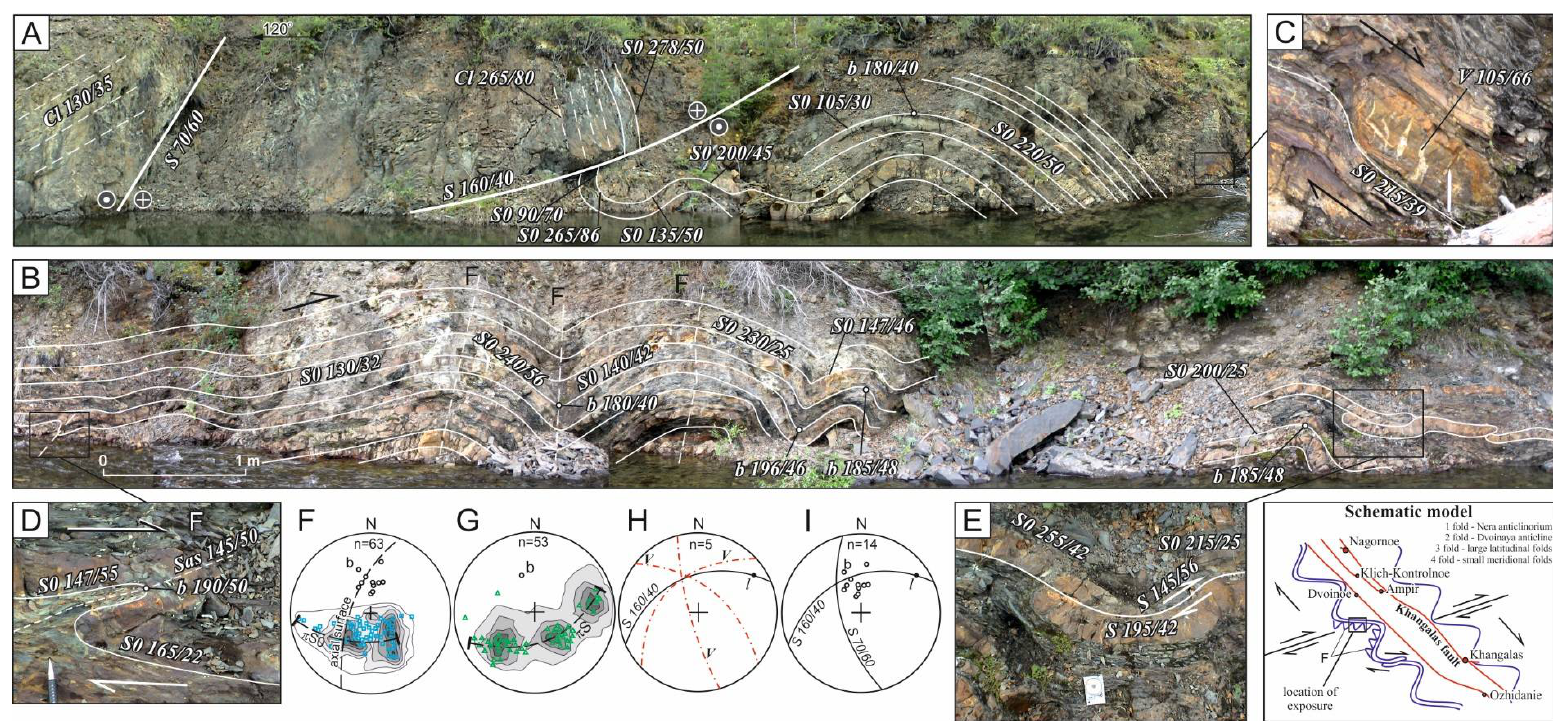
Figure 8. Dextral strike-slip deformations in Upper Triassic sandy siltstones, Mudeken Creek. ( A , B ) Fold and fault structures; ( C ) ladder veins in sandstone beds (plan view); ( D ) shaped overturned fold (plan view); ( E ) dextral strike-slip fault (plan view); ( F – I ) diagrams: ( F ) bedding poles, ( G ) cleavage poles, ( H ) projection of quartz-carbonate veins shown in ( С , I ) projections of faults and hinges of folds; l , direction of tectonic transportation. Contours of poles to planes (per 2% area).